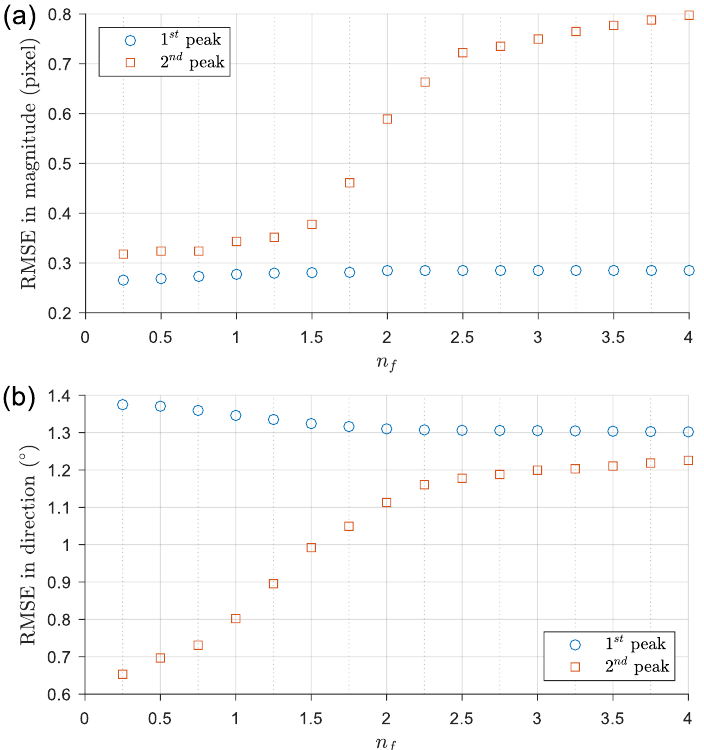
Figure 11. RMSE in ( a ) magnitude and ( b ) direction against different 𝑛 𝑓 for the two velocity fields (corresponding to 1st peak and 2nd peak) derived from case PIVB . Note that the magnitude is converted from mm/s to pixel.